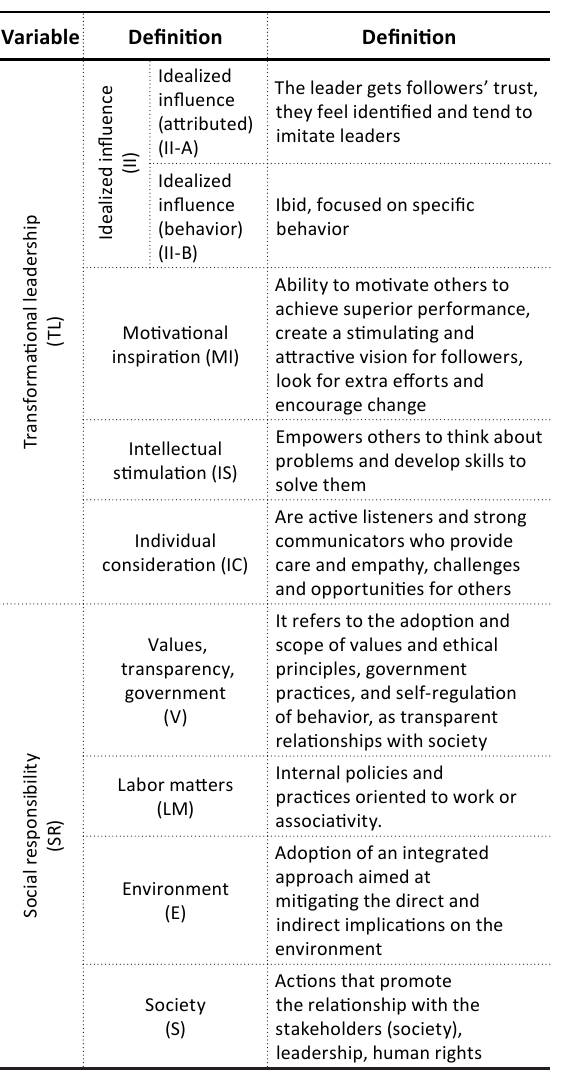
Table 1. Definition and